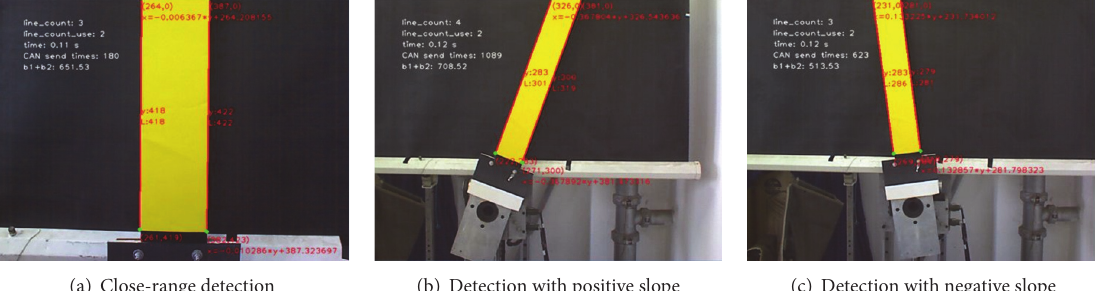
Figure 12: Edge line detection results under the different position and attitude.